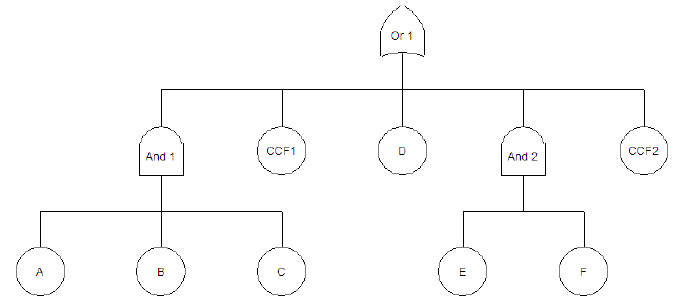
Figure 12. Fault tree for SIS system.